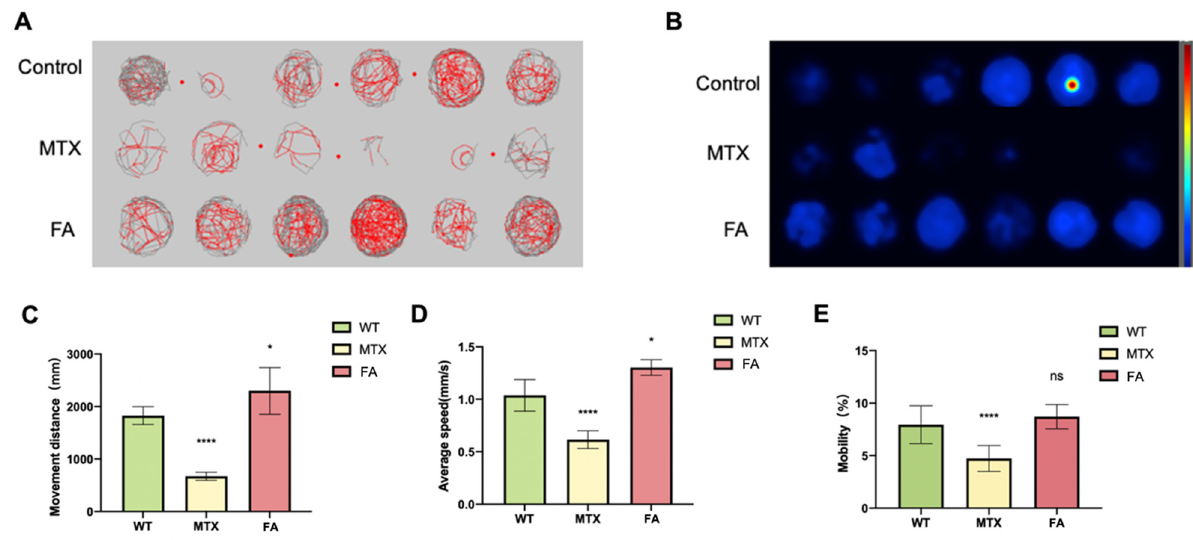
Figure 3. Zebrafish Behavioral Experimental Data Statistics. ( A ) Digital tracks of larvae from wildtype (WT), MTX 1 mM and FA 1 mM groups at 5 dpf. ( B ) Heat maps of the digital tracks A. ( C ) The ten-minute activity distance statistics of zebrafish embryos in different groups. ( D ) Statistics on the average activity speed of zebrafish embryos in different groups. ( E ) Mobility statistics of zebrafish embryos in different groups. (Student t -test, * p < 0.05, **** p < 0.0001, ns: no statistical difference.).